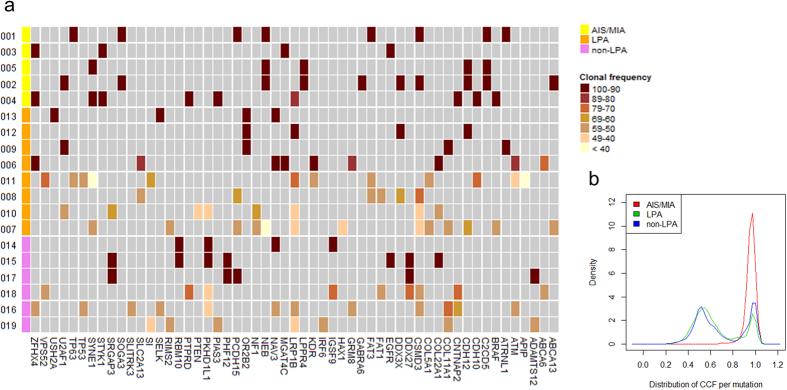
Cancer cell fraction (CCF) of top deleterious non-synonymous mutations (55 genes).(a) Revealed a pattern of clonal frequency among the three groups. More diverse clonal frequency was found in both adenocarcinoma with predominant lepidic pattern (LPA) and adenocarcinoma with predominant histologic subtype other than lepidic pattern (non-LPA) while homogeneous clonal frequency was found in AIS/MIA. (b) Density plot of posterior probability distribution of CCF of all mutations according to group revealed the same finding as deleterious non-synonymous mutations.